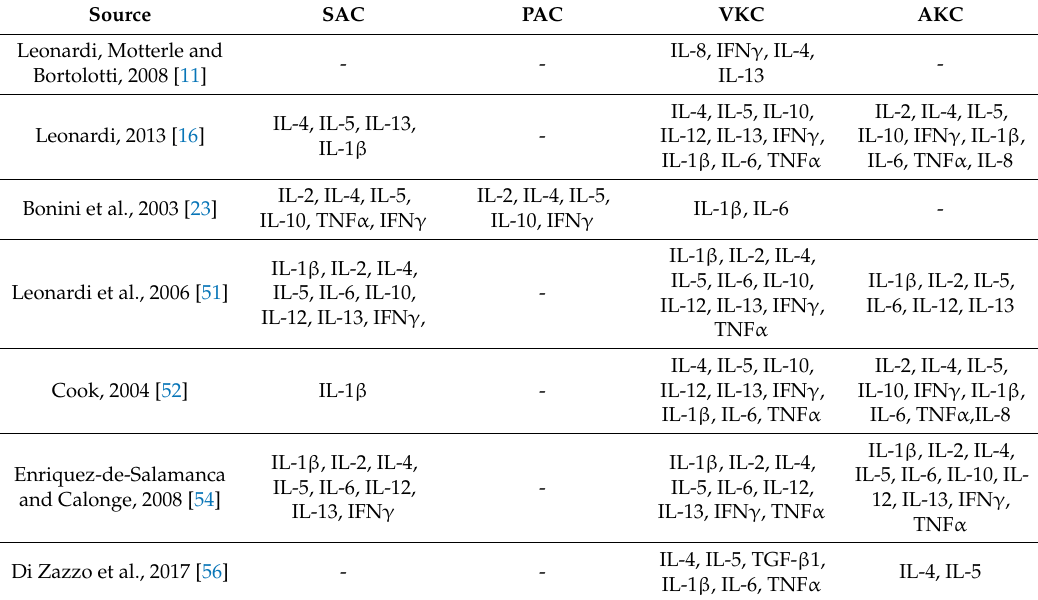
Table 4. Overview of recent literature and measured cytokine concentrations in seasonal allergic conjunctivitis (SAC), perennial allergic conjunctivitis (PAC), vernal keratoconjunctivitis (VKC), atopic keratoconjunctivitis (AKC) from 2003 to 2019 [11,16,23,40,43,44,51–57]. IL, interleukin; TNF, tumour necrosis factor; IFN,